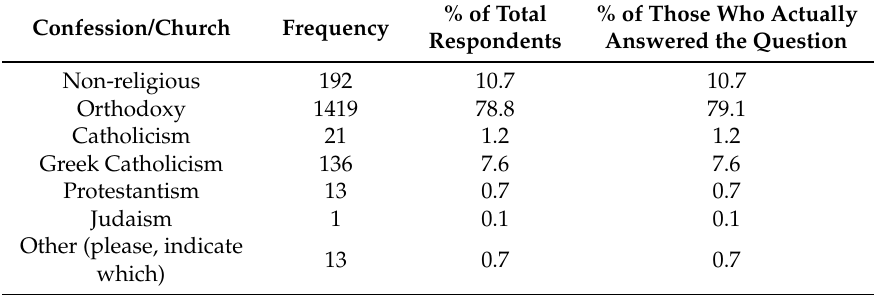
Table 1. Responses to the question “To which confession/church do you belong?” ( n = 1800, response